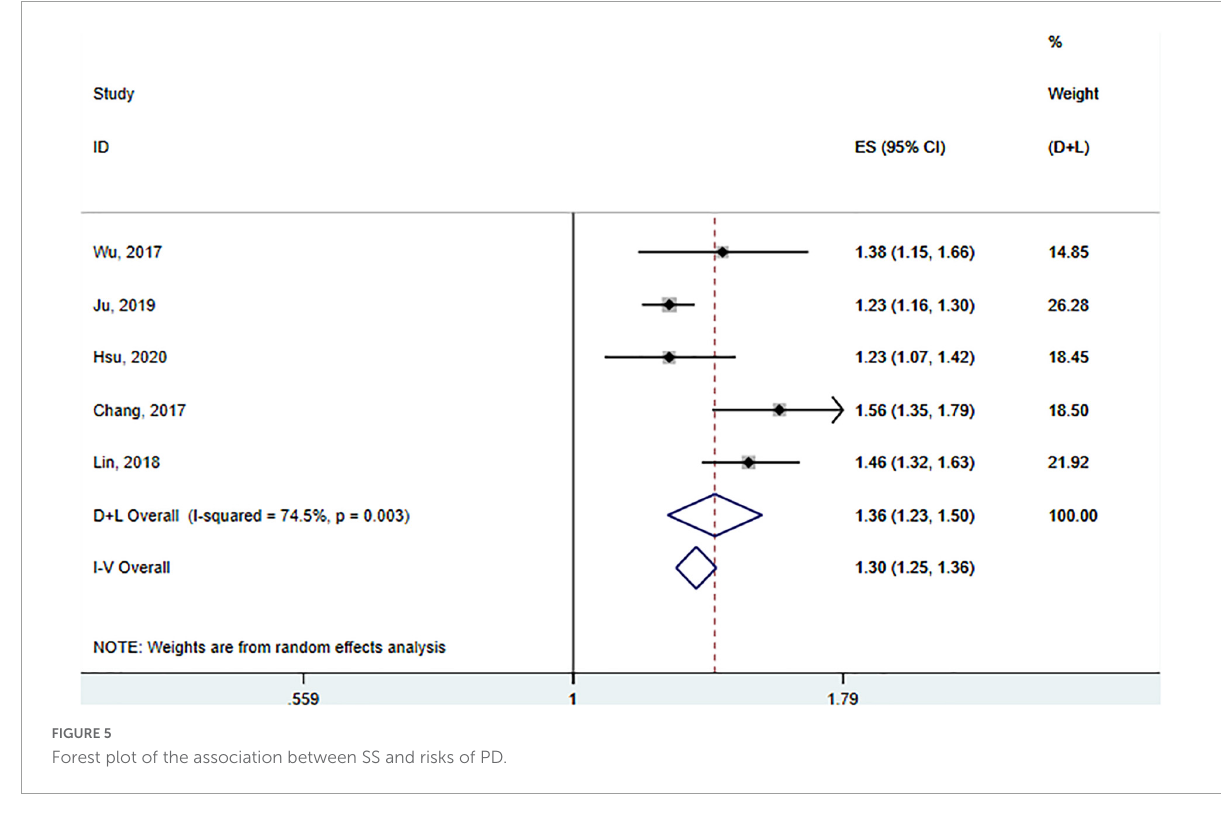
TABLE 4 Subgroup analysis of the association between SS and risk of